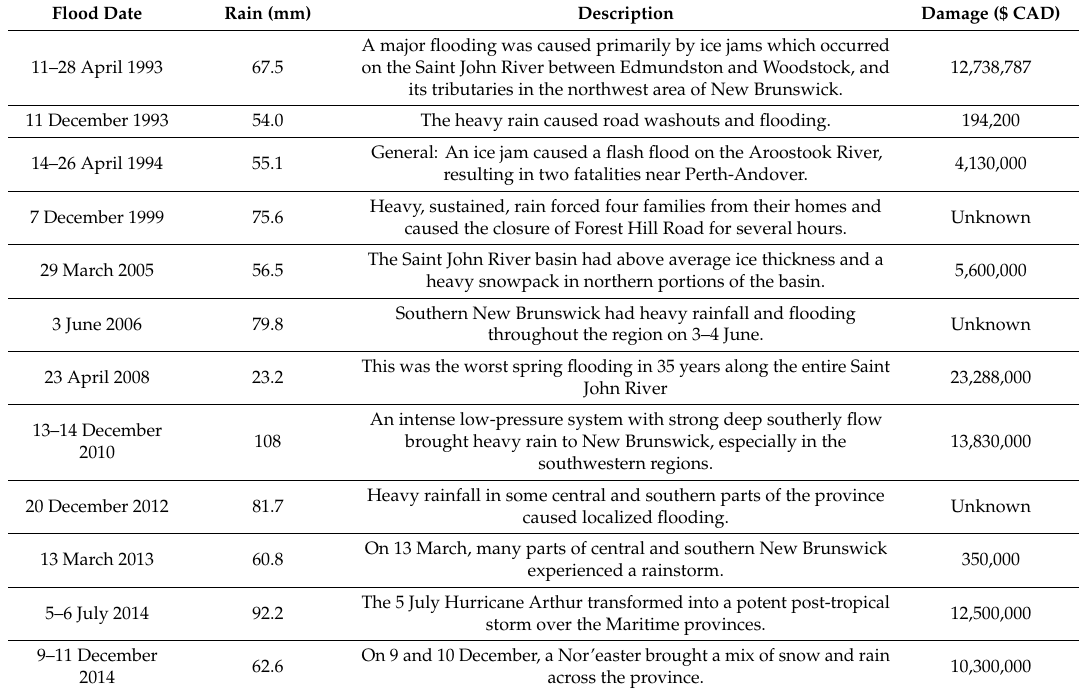
Table 2. Information about twelve out of sixty floods reported for Fredericton caused by heavy rains during 1988–2018 period. (Source: New Brunswick Government Department of Environment and Local Government website https: // www.elgegl.gnb.ca / 0001 / en / Flood /